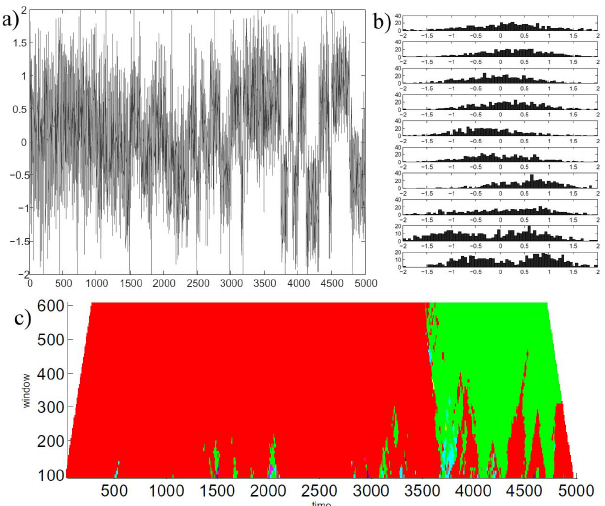
Fig. 2. Test of potential analysis on artificial data from a sys- tem bifurcating from one state to two. Here the underlying po- tential changes smoothly from one-well to double-well, described by the stochastic potential equation with varying potential wells (10 chunks of 500 points each), with the bifurcation occurring at time 3500: (a) artificial data generated from the changing potential function with a noise level 1; (b) histograms of 10 chunks of data, from top to bottom, corresponding to consequent subsets of the se- ries; (c) contour plot of number of detected states, where red=1 de- tected state, green=2. Results plotted as a function of sliding win- dow length at the middle of the window.